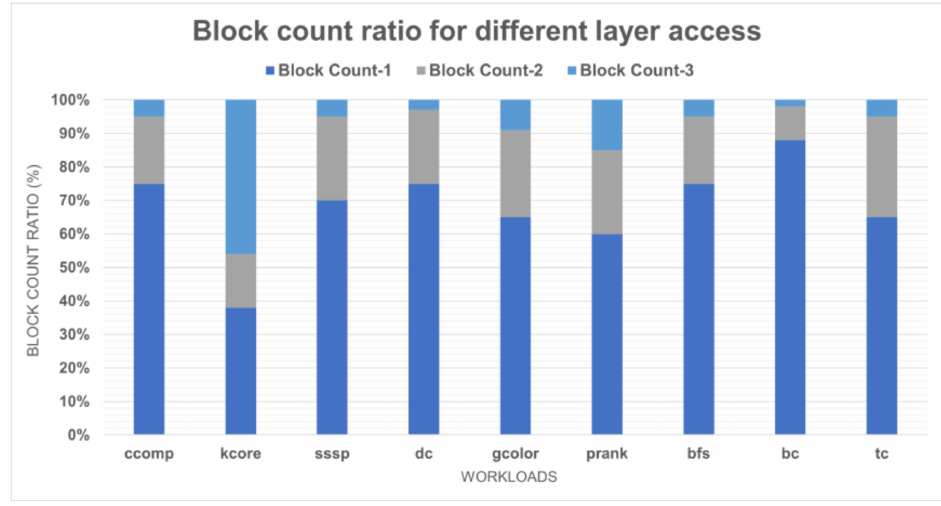
Figure 15. Block count ratio for different correlated line